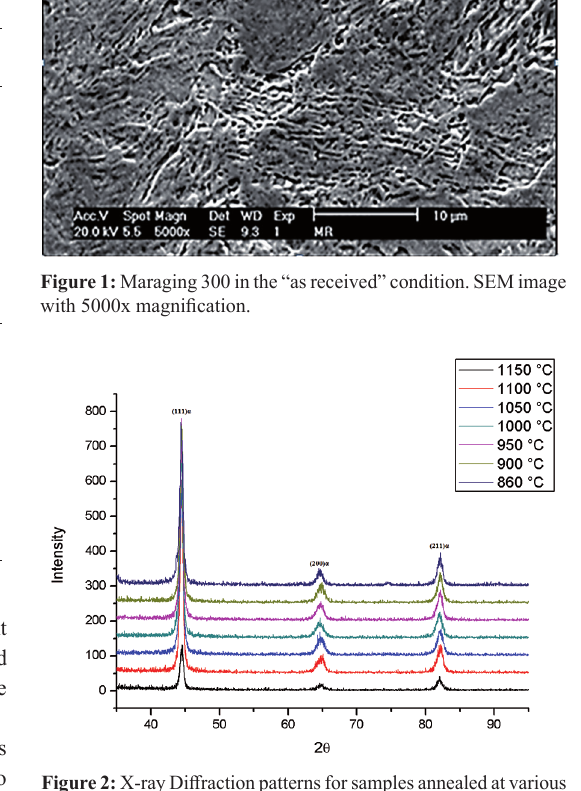
Figure 2: X-ray Diffraction patterns for samples annealed at various temperatures and aged at 480